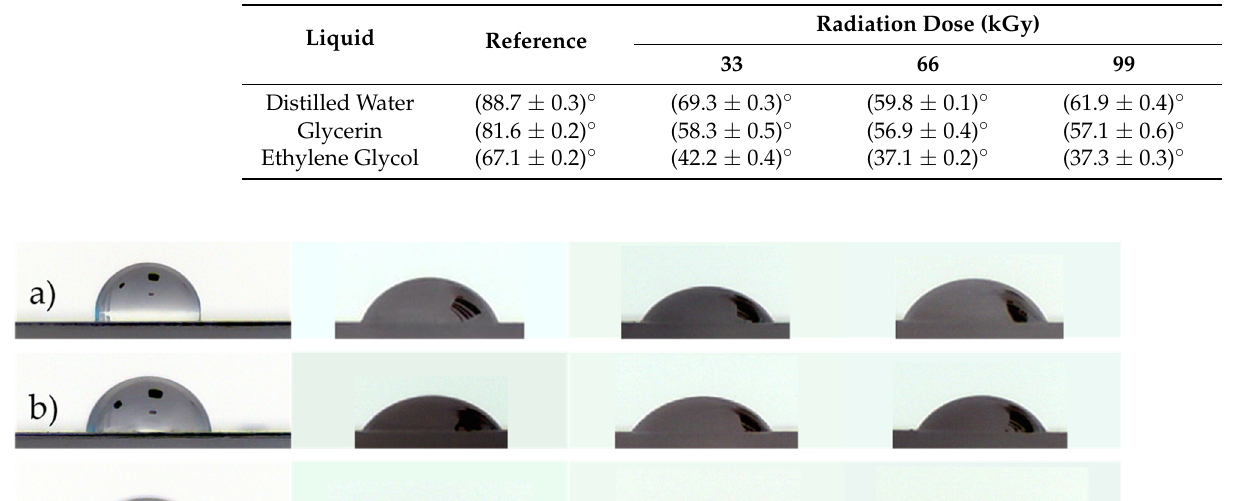
Figure 4. Liquid droplets on surfaces of test material (depending on plasma power): ( a ) distilled water, ( b ) glycerin, and ( c ) ethylene glycol. Table 4. Wetting contact angles of PP materials (depending on radiation dose).